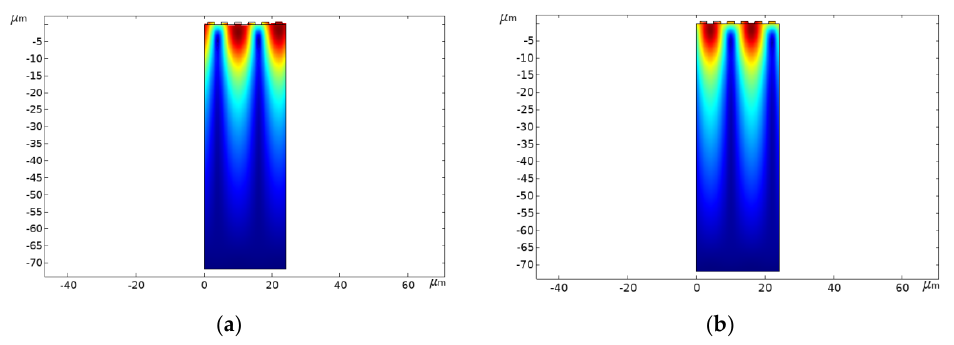
Figure 3. ( a , b ) Symmetrical and anti ‐ symmetrical modes of Al electrode, respectively.